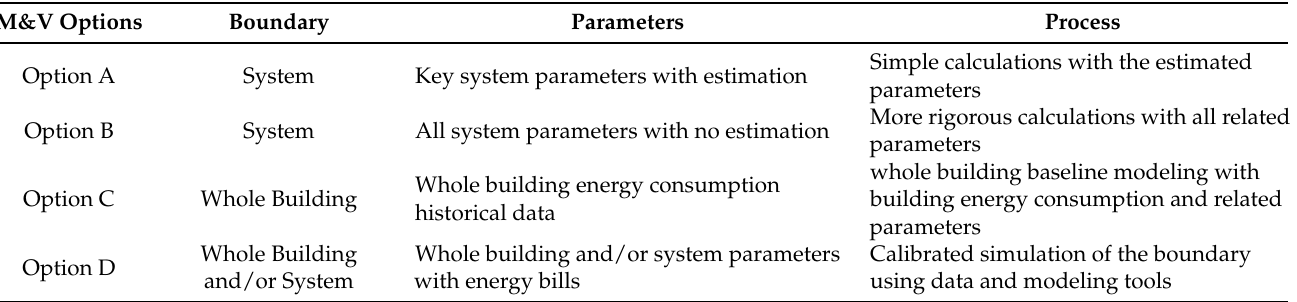
Table 1. IPMVP M&V